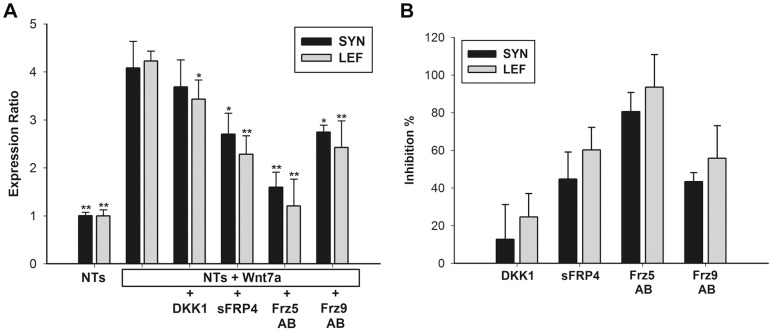
Inhibitory effects of Wnt inhibitors and blocking antibodies in Wnt7a-induced synapsin expression.(A) As described in "Materials and Methods", mRNA levels of SYN1 and LEF1 were examined by a qPCR. sFRP4 showed significant inhibition of SYN1 expression, and Frz5 blocking antibodies greatly inhibited gene expressions. Levels were normalized to those in NTs groups (set to 1.0). * p<0.05, ** p<0.01 (NTs+Wnt7a vs. all groups). (B) Percentages of inhibition calculated from (A). Data are presented as the mean ± SD of one triplicate experiment that was representative of three independent experiments.